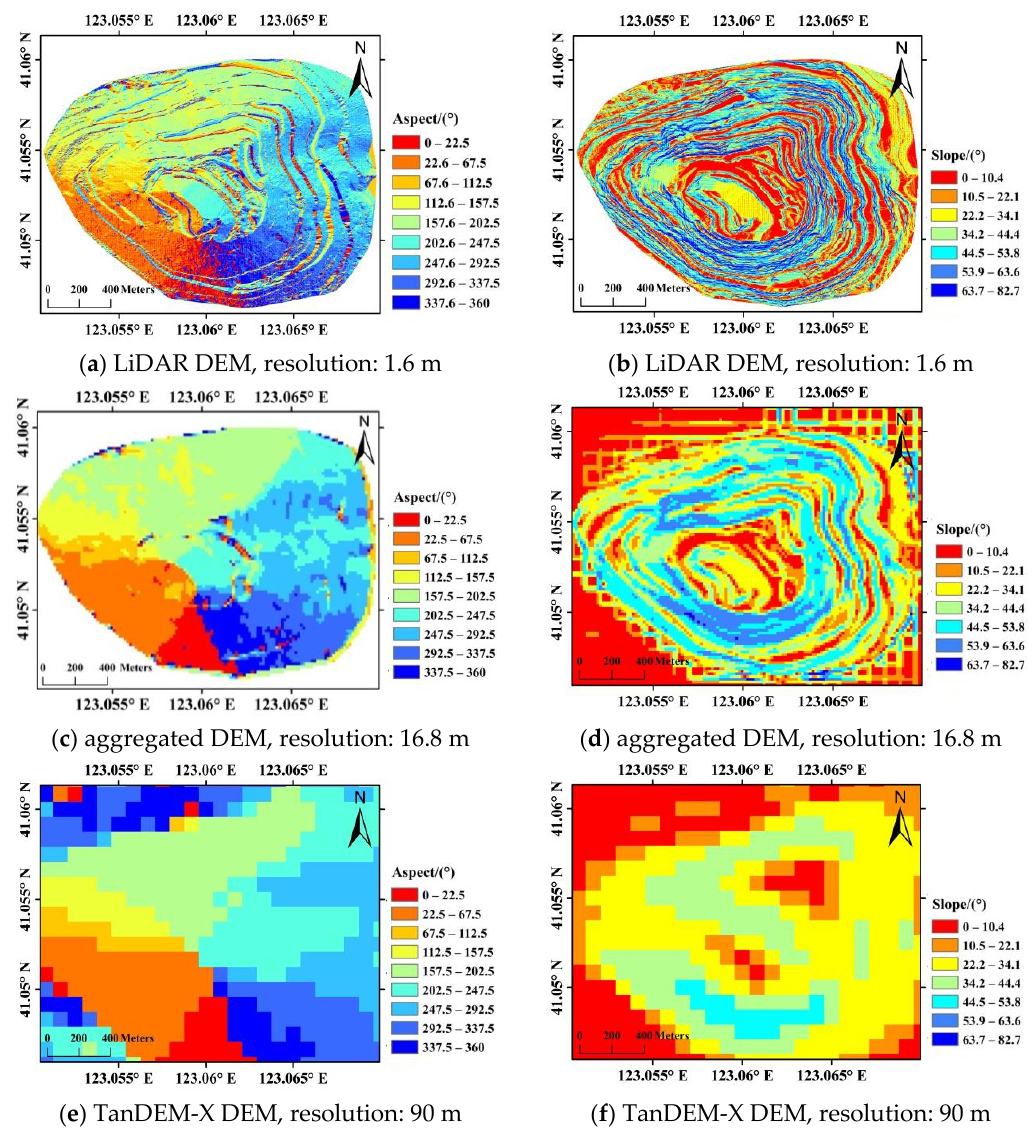
Figure 6. Slope aspects and angles derived from the LiDAR DEM ( a , b ), aggregated DEM ( c , d ), and TanDEM-X DEM ( e , f ), respectively.